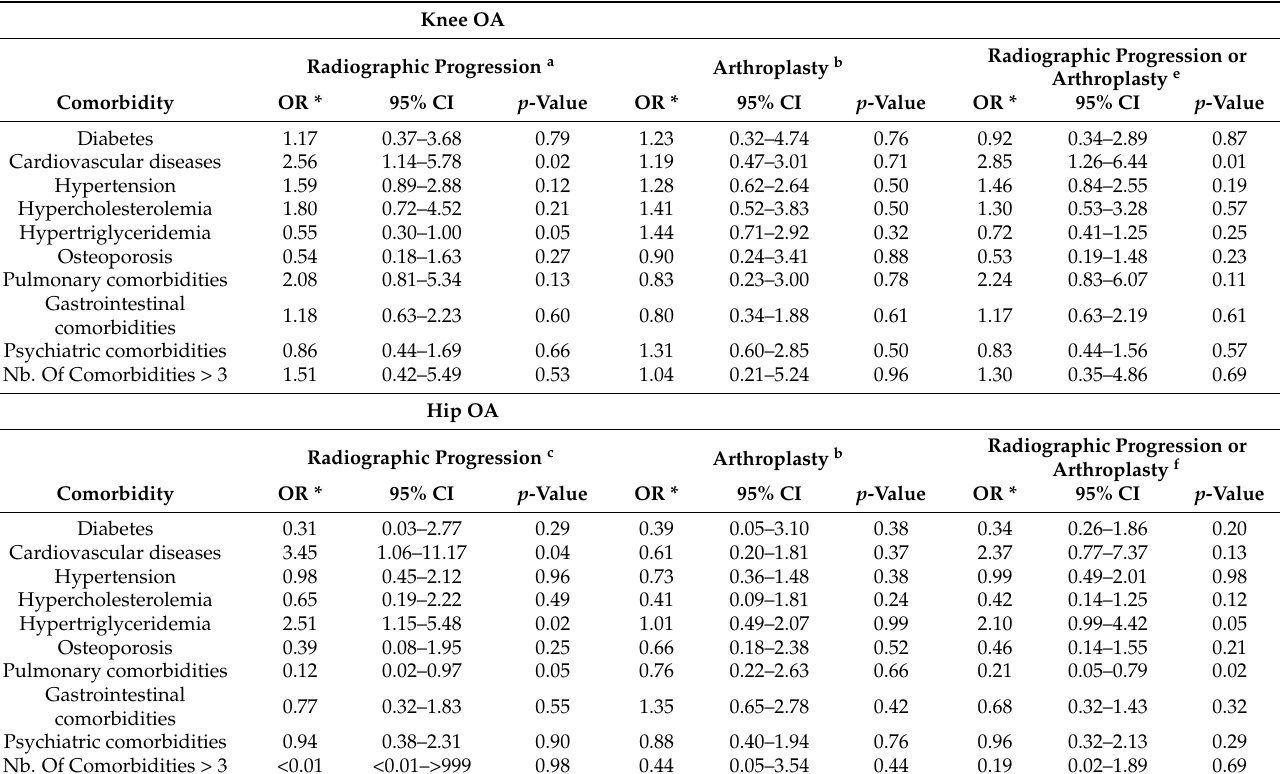
Table 3. Risk of progression and arthroplasty of knee and hip osteoarthritis during the 5-year follow-up associated with studied comorbidities (absence of comorbidity is the reference category). * Odds ratios and 95%confidence intervals adjusted for age, gender and